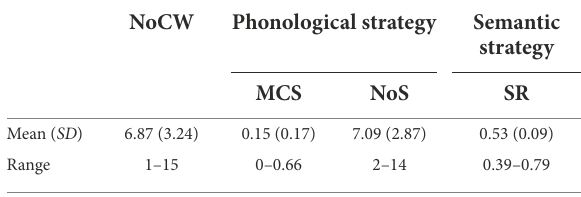
TABLE 1 Descriptive statistics of phonological and semantic strategy